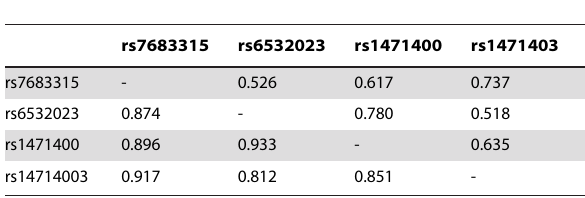
Table 4. Estimation of LD between each pair of